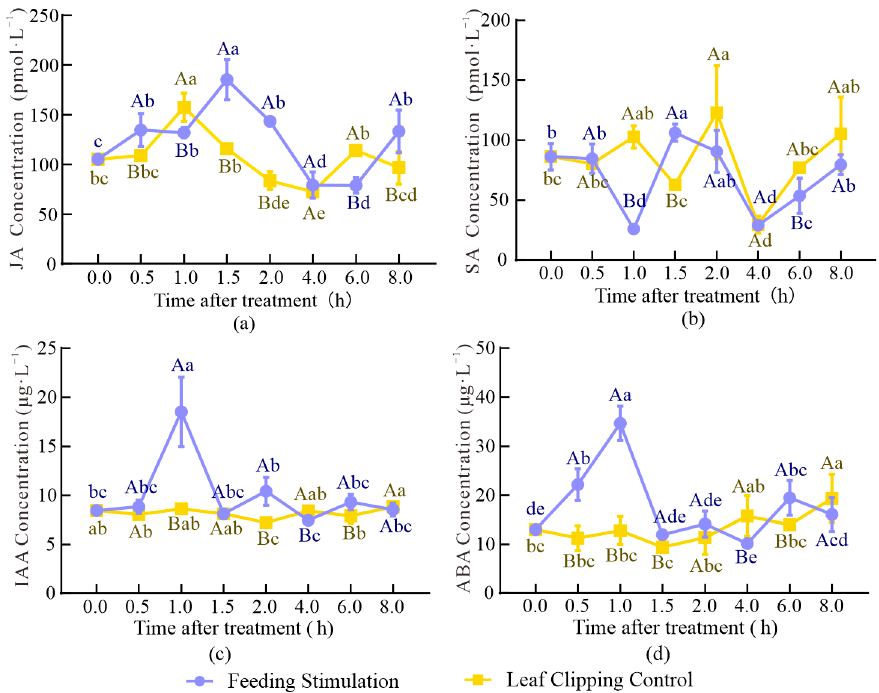
Figure 5. Concentration of JA ( a ), SA ( b ), IAA ( c ), and ABA ( d ) at different times after treatment. The data involved in this article were the mean ± SD (n = 3). Different uppercase letters meant significant differences between different treat modes and the same time after treatment at the p < 0.05 level. Different lowercase letters meant significant differences between different time after treatments and the same treat mode at the p < 0.05 level.